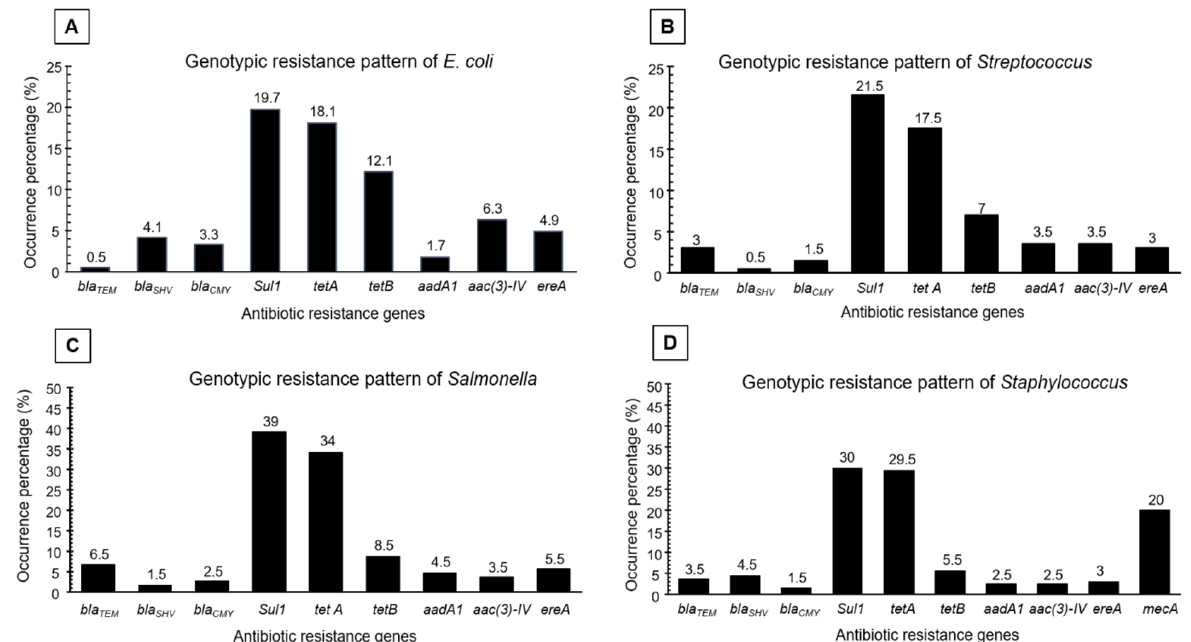
Figure 3. Genotypic resistance pattern of ( A ) E. coli , ( B ) Streptococcus , ( C ) Salmonella , and ( D ) Staphylococcus recovered from both livestock and poultry food products & by-products.